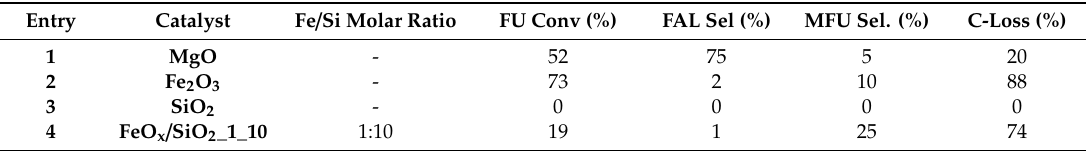
Table 4. Summary of the catalytic performances of silica-supported iron oxide and comparison with bulk Fe 2 O 3 and